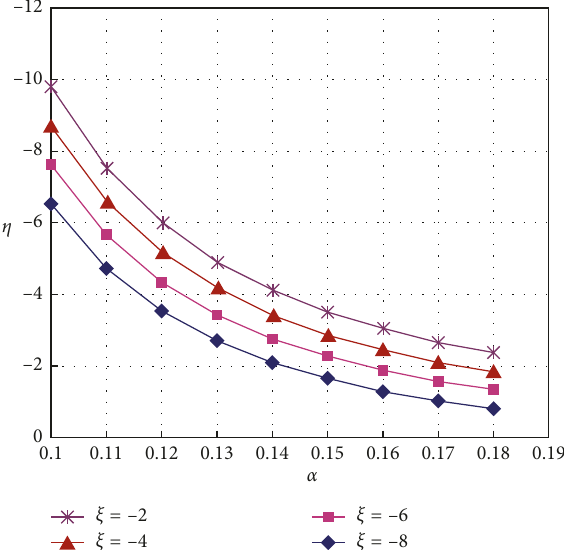
Figure 4: Relationship between plastic limit loads and SD effect considering the effect of ζ .